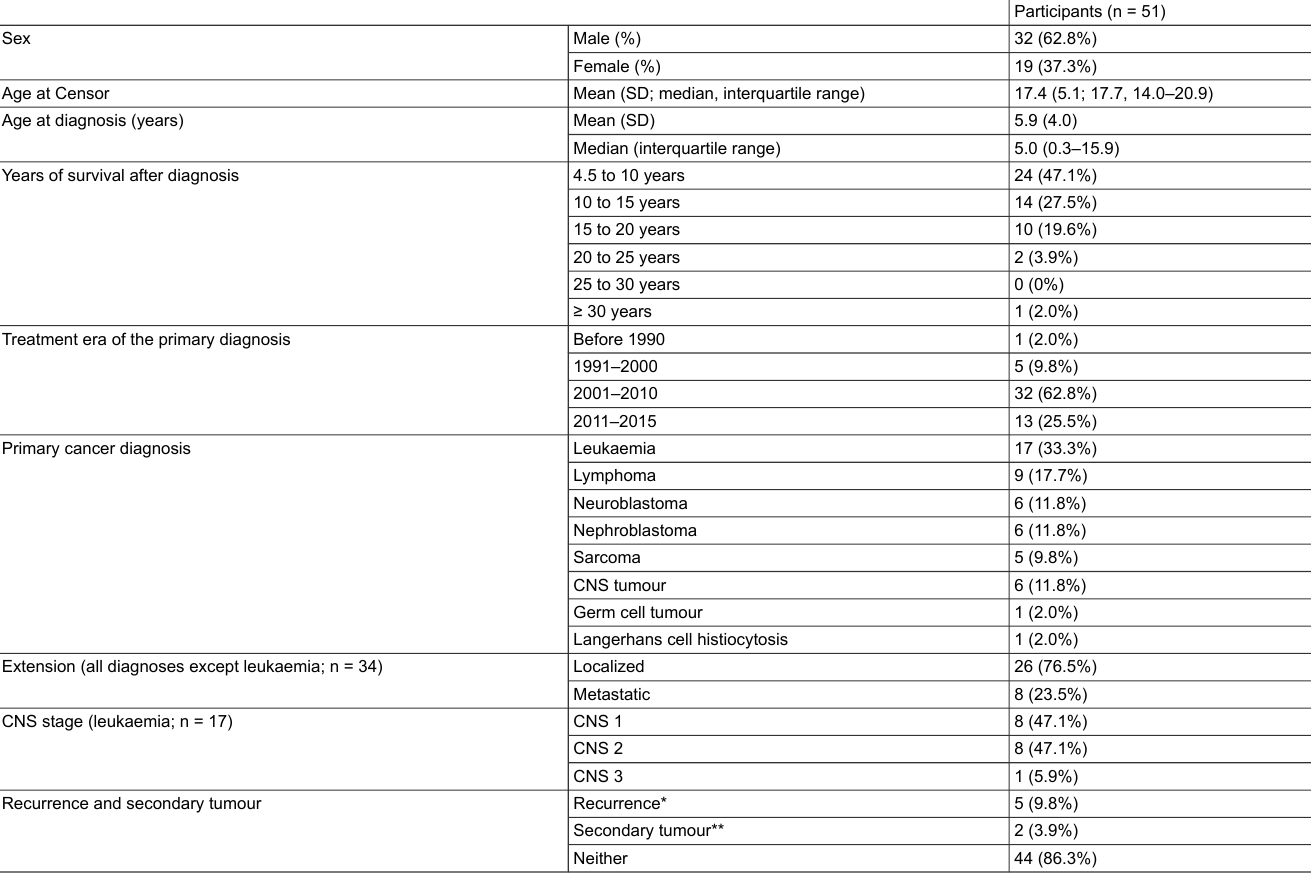
Table 1: Demographics of the participants in the LTFU outcome